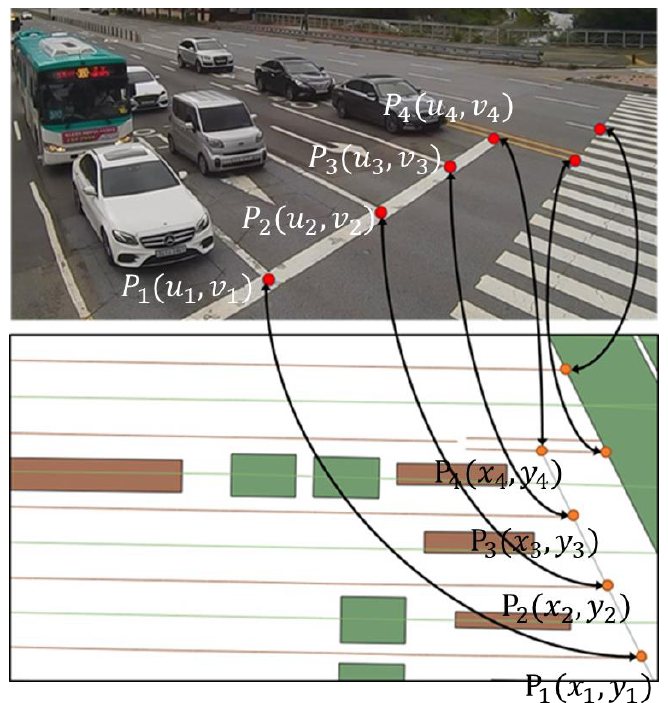
Figure 4. Road line and critical path in the HD map and aerial image.